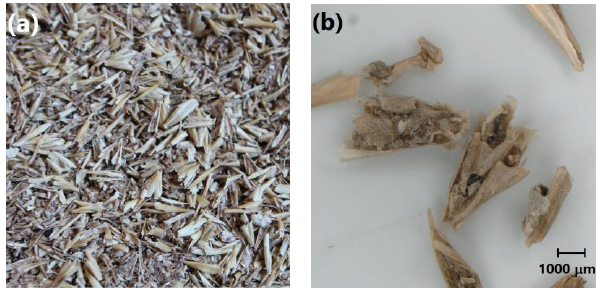
Figure 2. Macroscopic ( a ) and microscopic ( b ) appearance of applied brewers’ spent grain (BSG) before extrusion